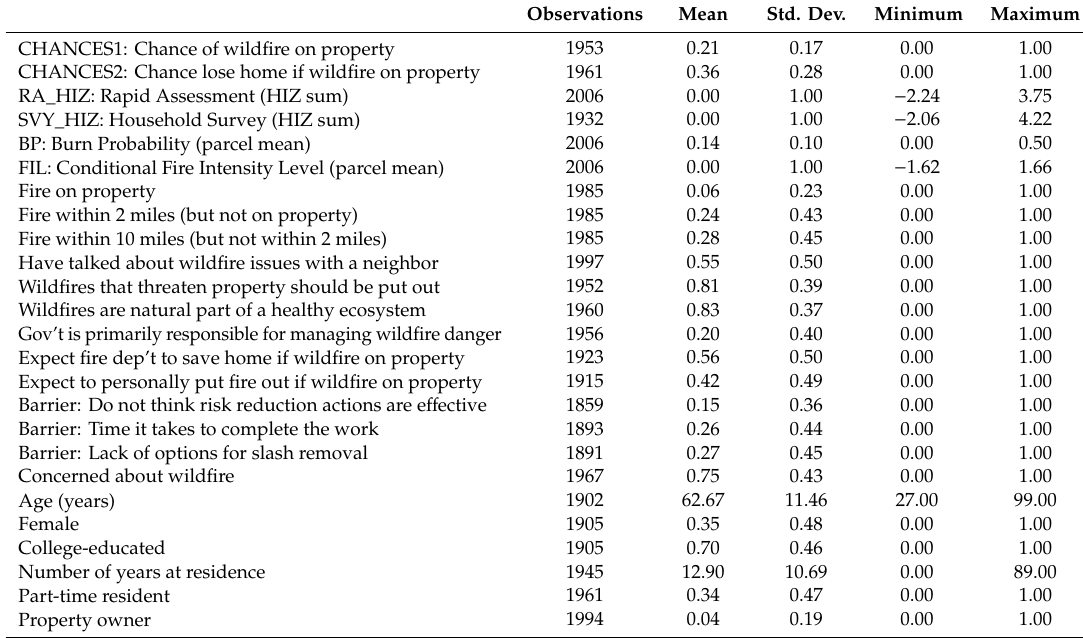
Table 1. Descriptive statistics for wildfire risk-related assessments and survey responses related to resident characteristics and perceptions of wildfire